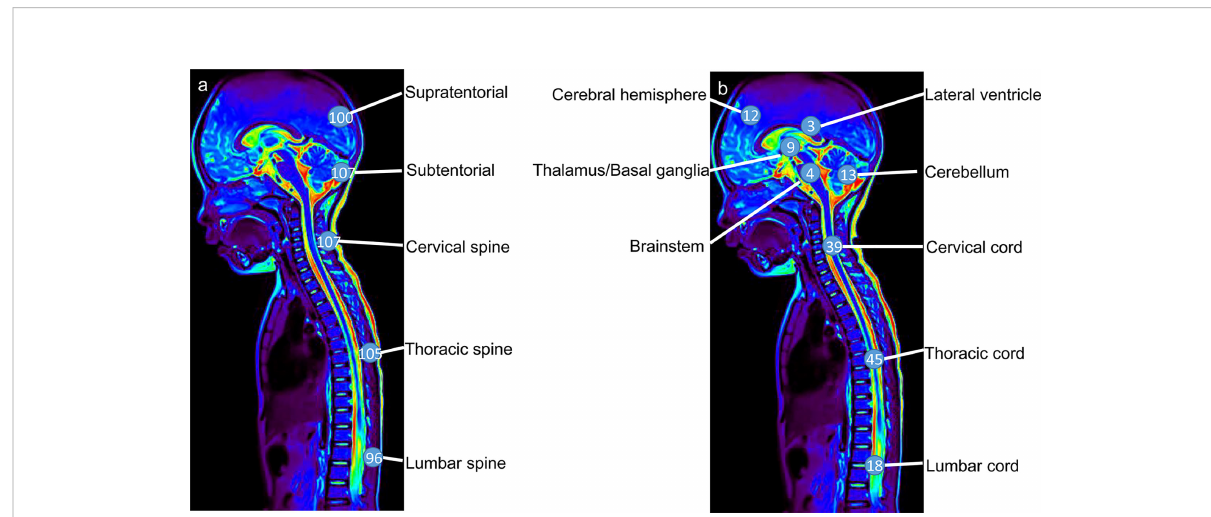
FIGURE 5 The lesions (A) and parenchymal tumor (B) location in patients with diffuse leptomeningeal glioneuronal tumors. Numbers in circles represent the numbers of lesions (A) and parenchymal tumors (B) in the speci fi c